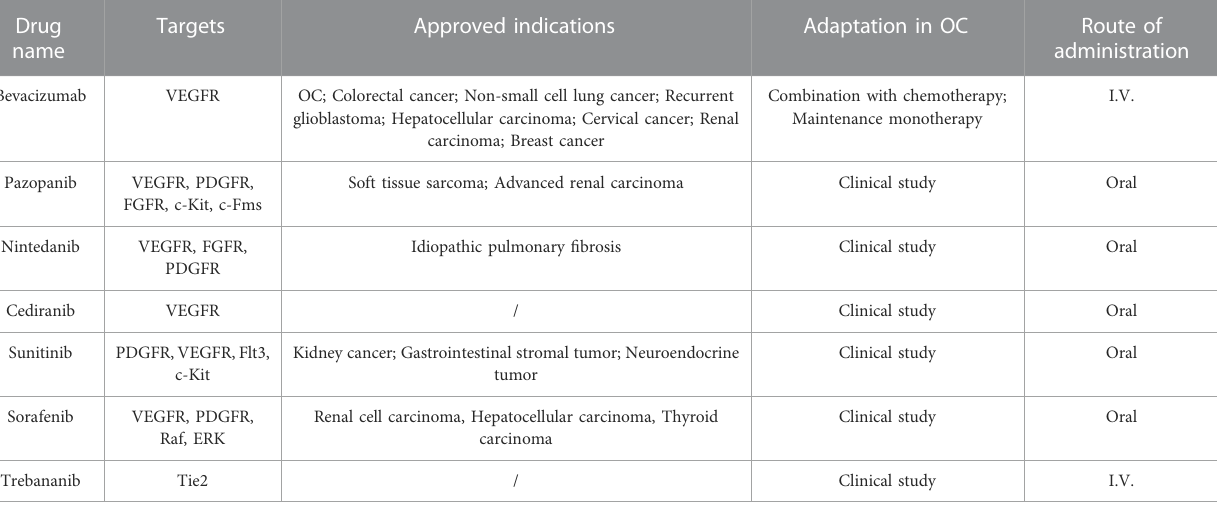
TABLE 1 Summary of anti-angiogenic agents in